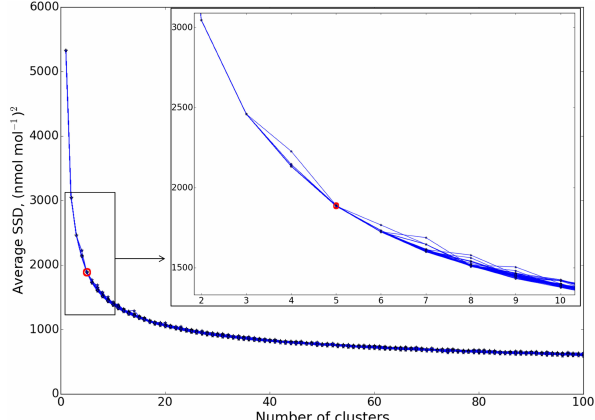
Figure 1. Averaged SSD (“elbow” plot) of 50 · 100 independent k - means runs with varying number of clusters k from 1 to 100, based on the first set of